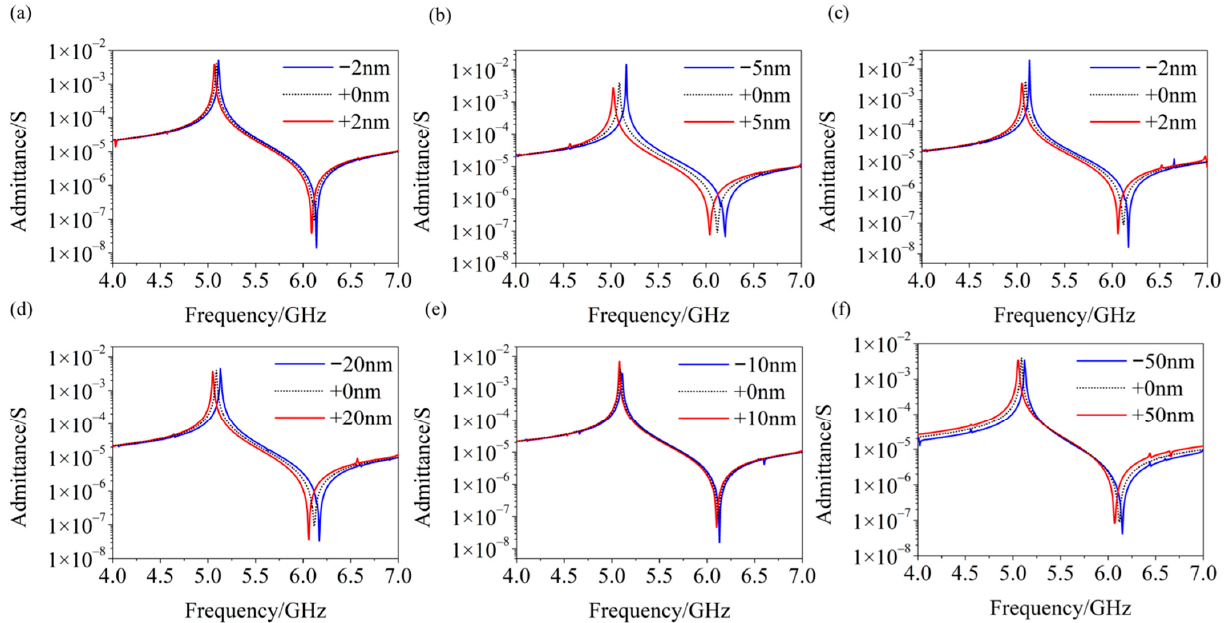
Figure 8. Performance of the SM-YBAR after several main geometric parameters deviate from their design values. ( a ) The thickness of the top electrode (Al, 50 ± 2 nm); ( b ) Thickness of the LiNbO 3 film (200 ± 5 nm); ( c ) Thickness of the bottom electrode (Pt, 50 ± 2 nm); ( d ) Thickness of the SiO 2 layers in the Bragg reflector (174 ± 20 nm); ( e ) Thickness of the Pt layers in the Bragg reflector (60 ± 10 nm); ( f ) Electrode-width of the IDTs (500 ± 50 nm).